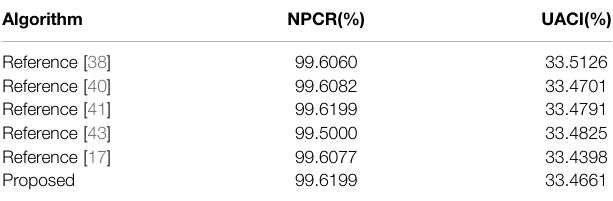
TABLE 7 | Comparison with other algorithms on differential